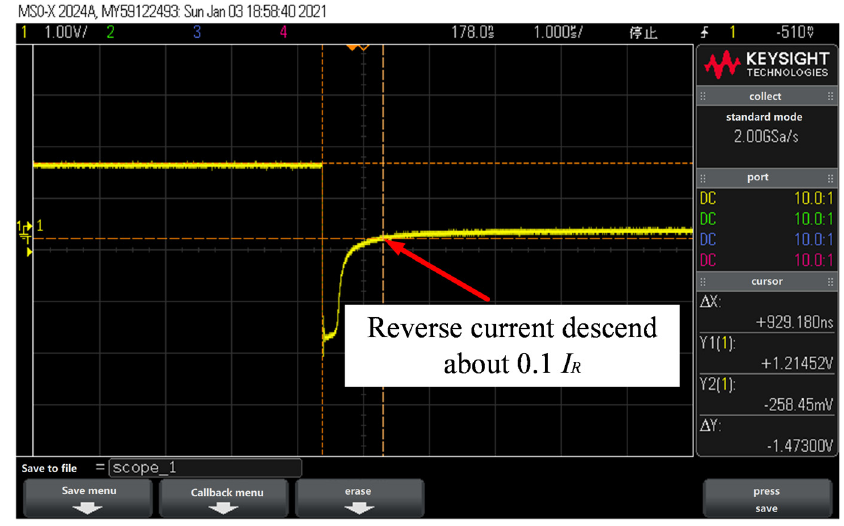
Figure 15. Test results of reverse recovery time t r